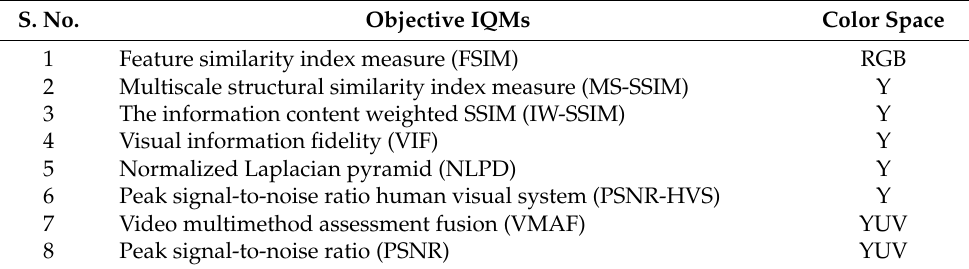
Table 1. Objective IQMs and the specified color space and channel used for metric calculation. S. No.